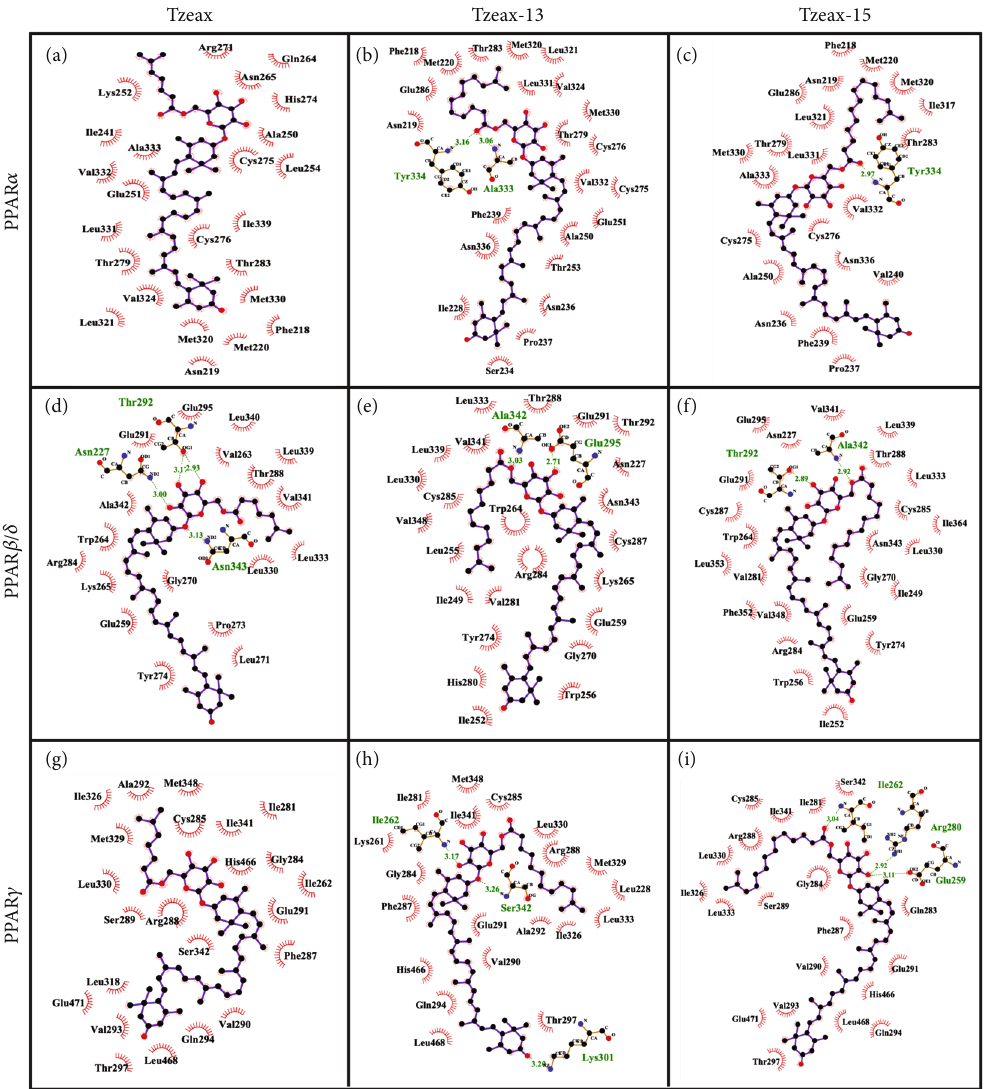
Figure 10: Interatomic interaction of thermozeaxanthins and PPAR-LBDs. Interatomic interaction of Tzeax with (a) PPAR α , (d) PPAR β / δ , and (g) PPAR γ , Tzeax-13 with (b) PPAR α , (e) PPAR β / δ , and (h) PPAR γ , and Tzeax-15 with (c) PPAR α , (f) PPAR β / δ , and (i) PPAR γ . All plots were generated using LigPlot. Labels in green correspond to residues involved in hydrogen bonds, and black one to those that interact by hydrophobic